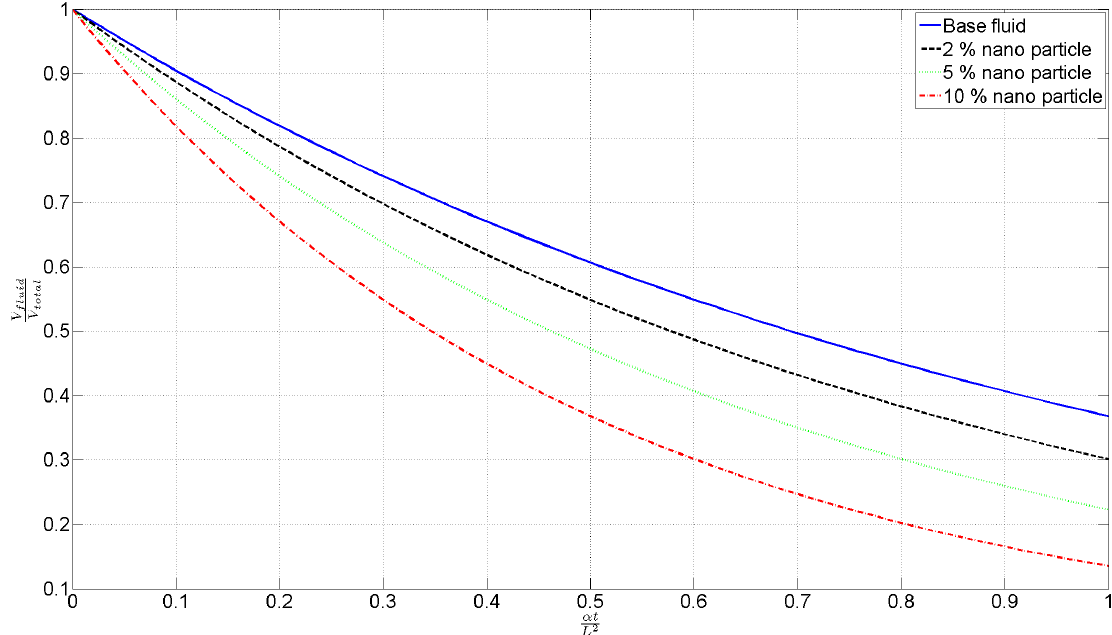
Figure 11. Time dependency of fluid volume